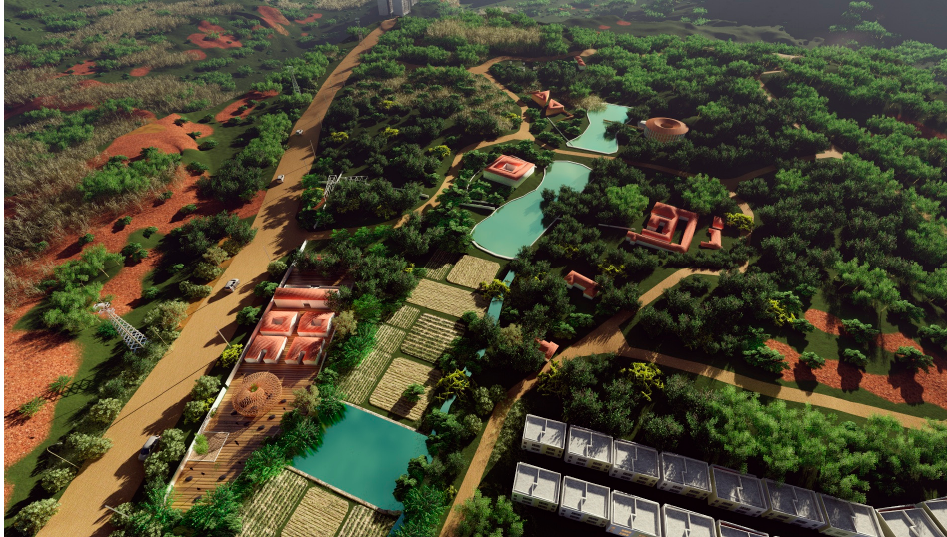
Figure 5. Plan, section and façade of the valley library designed starting from the tulou typology. Buildings 2016 , 6 , 42